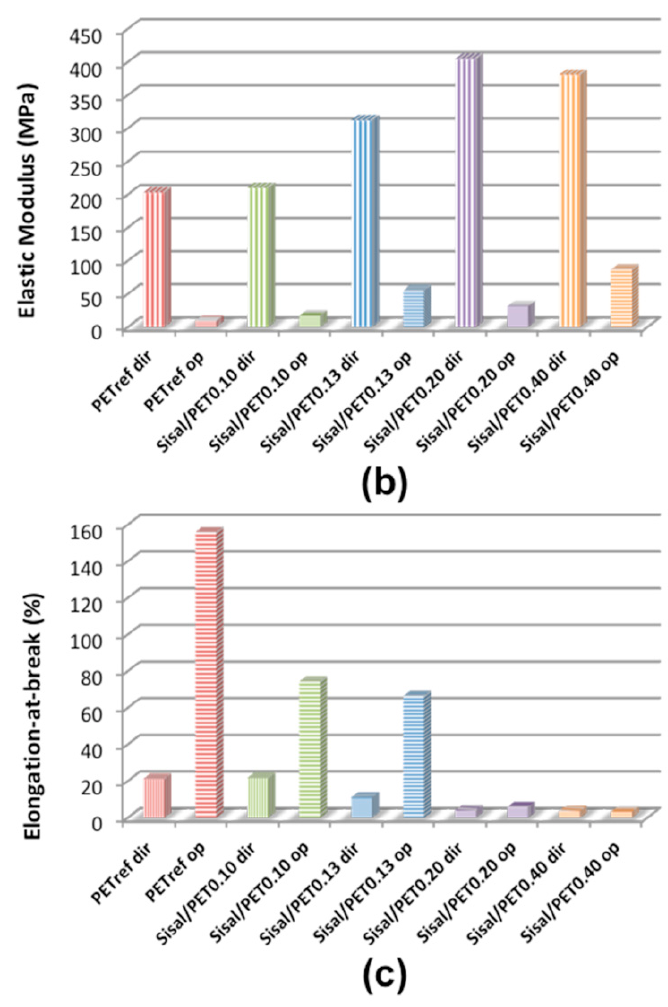
Figure 8. ( a ) Ultimate tensile strength (errors from ±0.10 (Sisal/PET 0.10 op ) to ±1.20 (Sisal/PET 0.10 dir )); ( b ) elastic modulus (errors from ±0.10 (Sisal/PET 0.13 op ) to ±15.63 (Sisal/PET 0.40 dir )); and ( c ) elongation ( b ) elastic modulus (errors from ± 0.10 (Sisal/PET 0.13 op ) to ± 15.63 (Sisal/PET 0.40 dir )); and ( c ) elongation at break (errors from ±0.01 (Sisal/PET 0.20 dir ) to ±17.53 (Sisal/PET 0.13 op )) of the electrospun mats. All at break (errors from ± 0.01 (Sisal/PET 0.20 dir ) to ± 17.53 (Sisal/PET 0.13 op )) of the electrospun